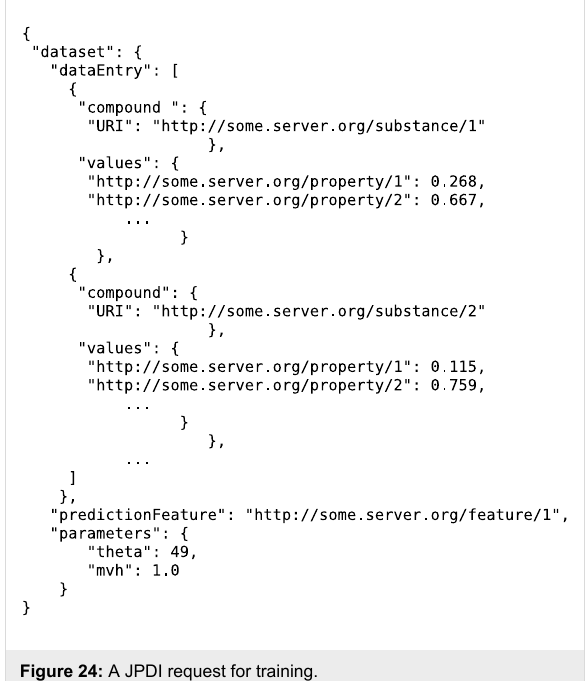
perform predictions requires (i) the model it has previously produced and (ii) a dataset containing values for the features it has